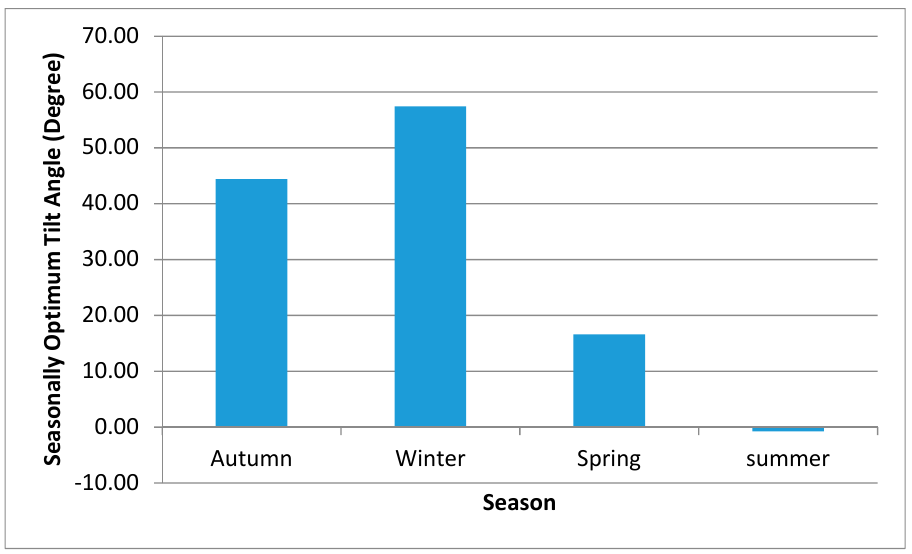
Figure 7. The seasonally optimum tilt angle β opt,s for di ff erent latitudes.